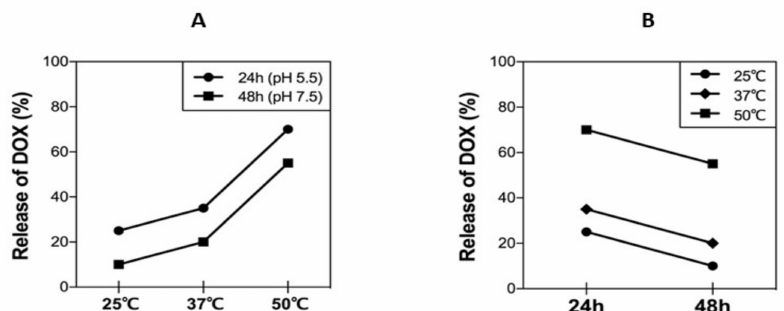
Figure 5. In vitro cumulative drug release profiles of DOX dispersed in PBS at 25 ◦ C, 37 ◦ C, and 50 ◦ C at 24 h and 48 h in pH = 5.5 and pH = 7.5. ( A ) Temperature-dependent release kinetics of DOX; ( B ) Time-dependent release kinetics of